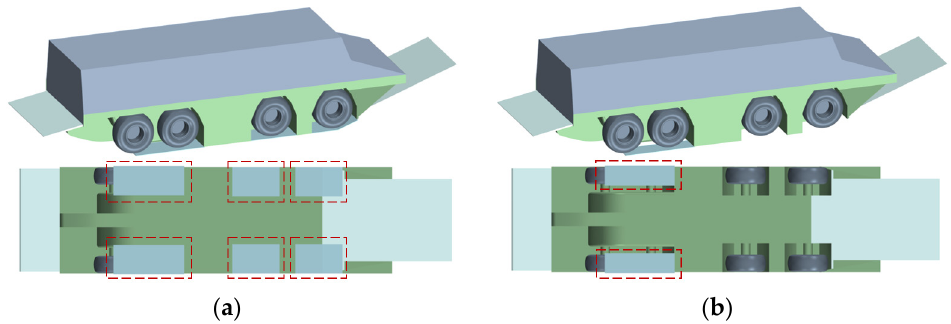
Figure 20. Geometry of the resistance improvement models, where the installed flap plates are shown in sky blue. ( a ) Geometry of the Model-2; ( b ) Geometry of the Model-3.